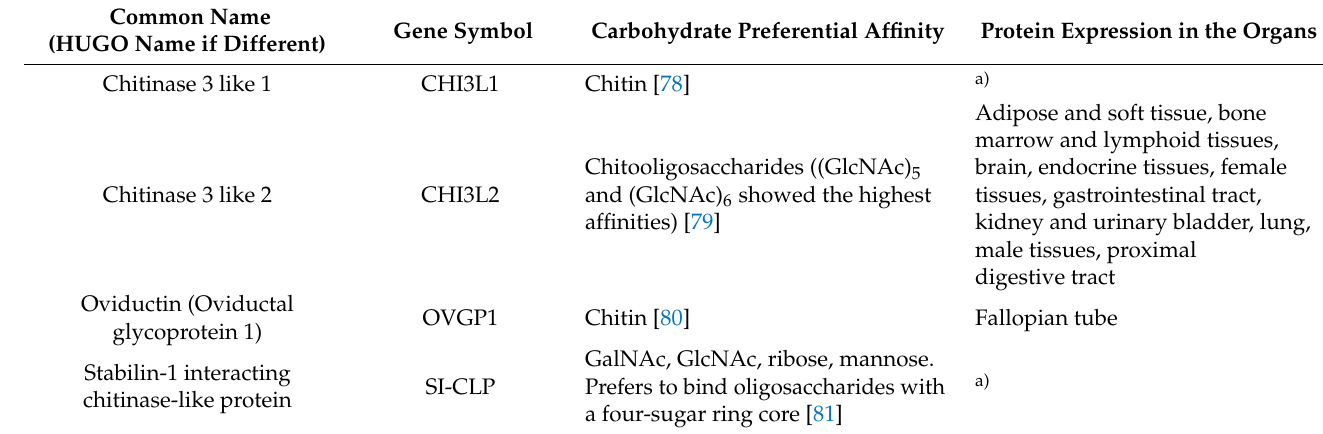
Table 2. Human chitolectins (also called chilectins), their carbohydrate ligands and protein expression in the